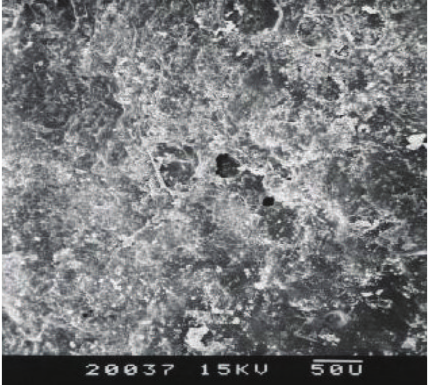
Figure 8: Membrane section of 30 ∘ C coated fertiliser ( ×